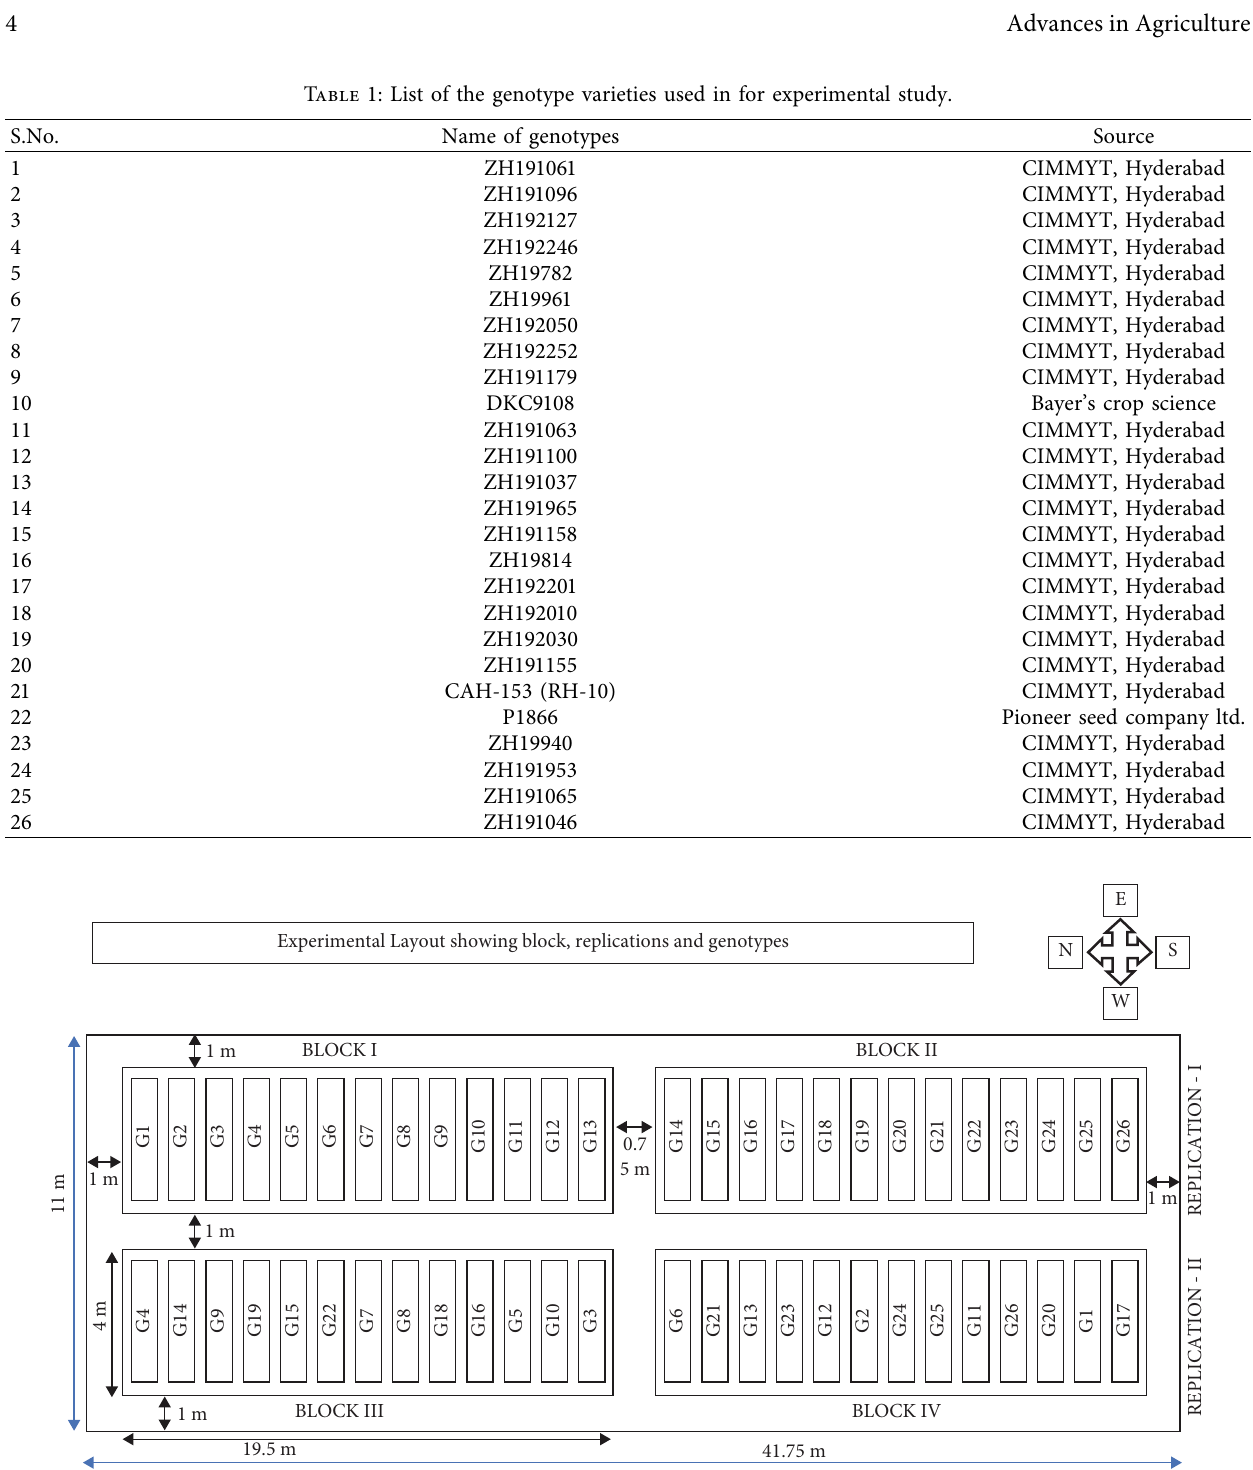
Figure 3: Experimental layout of alpha-lattice design for 26